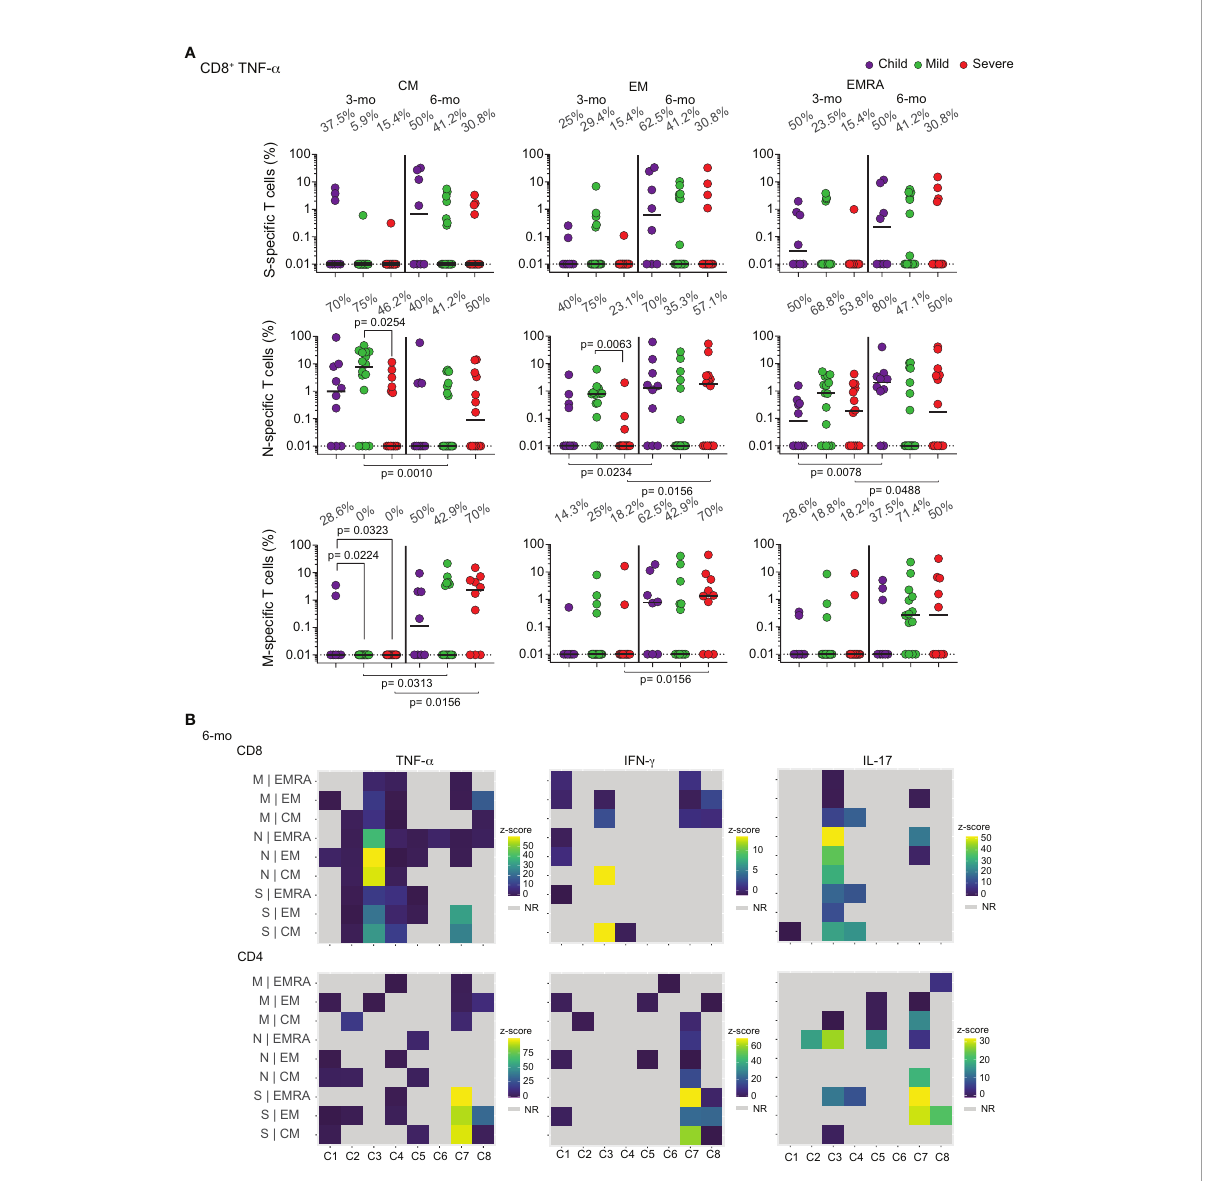
FIGURE 4 Longitudinal analysis of functional speci fi c memory T cells. (A) Individual frequencies of TNF- a production in memory T CD8 + cells collected at the 3 and 6-months post-acute infection, responding to in vitro challenge with different SARS-CoV-2 peptide pools to proteins S, N, or M, percentages of responders are indicated above columns. Differences between patients ’ groups at the same collection point were assessed by Kruskal-Wallis and Dunn ’ s post hoc test; differences between collection points were assessed by Wilcoxon test. (B) Heatmap illustrating CD8 + and CD4 + responses of 8 individual children to the different SARS-CoV-2 peptide pools. Data is shown as z-score, where patients who did not respond to stimuli are considered in light gray. C – individual children. NR – Non-responsive. CM – Central memory; EM – Effector memory; EMRA – Terminally differentiated effector memory